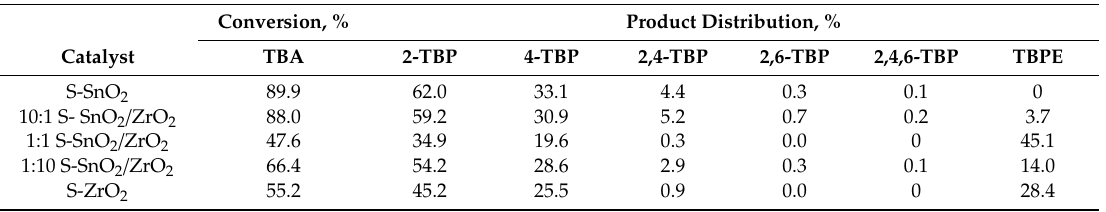
Table 2. Catalytic performance data of all synthesized catalysts for the tert-butylation of phenol